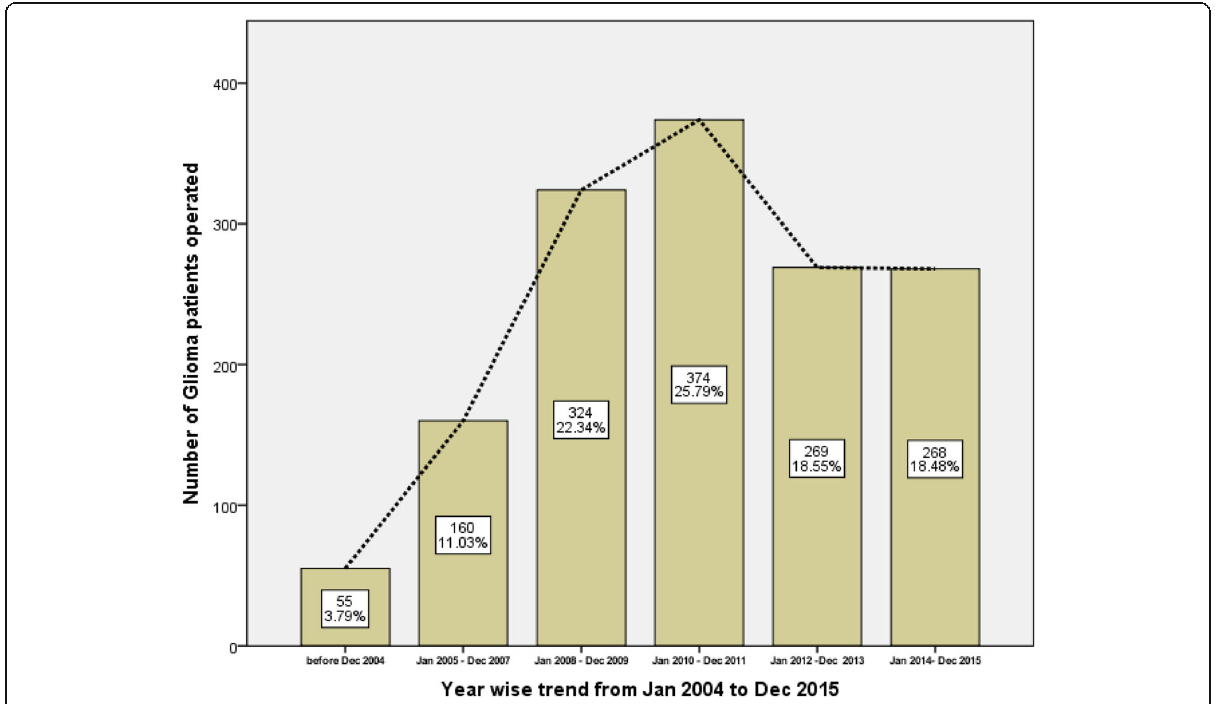
Fig. 3 Year wise trend showing increasing in prevalence of glioma patients from 2004 to 2015